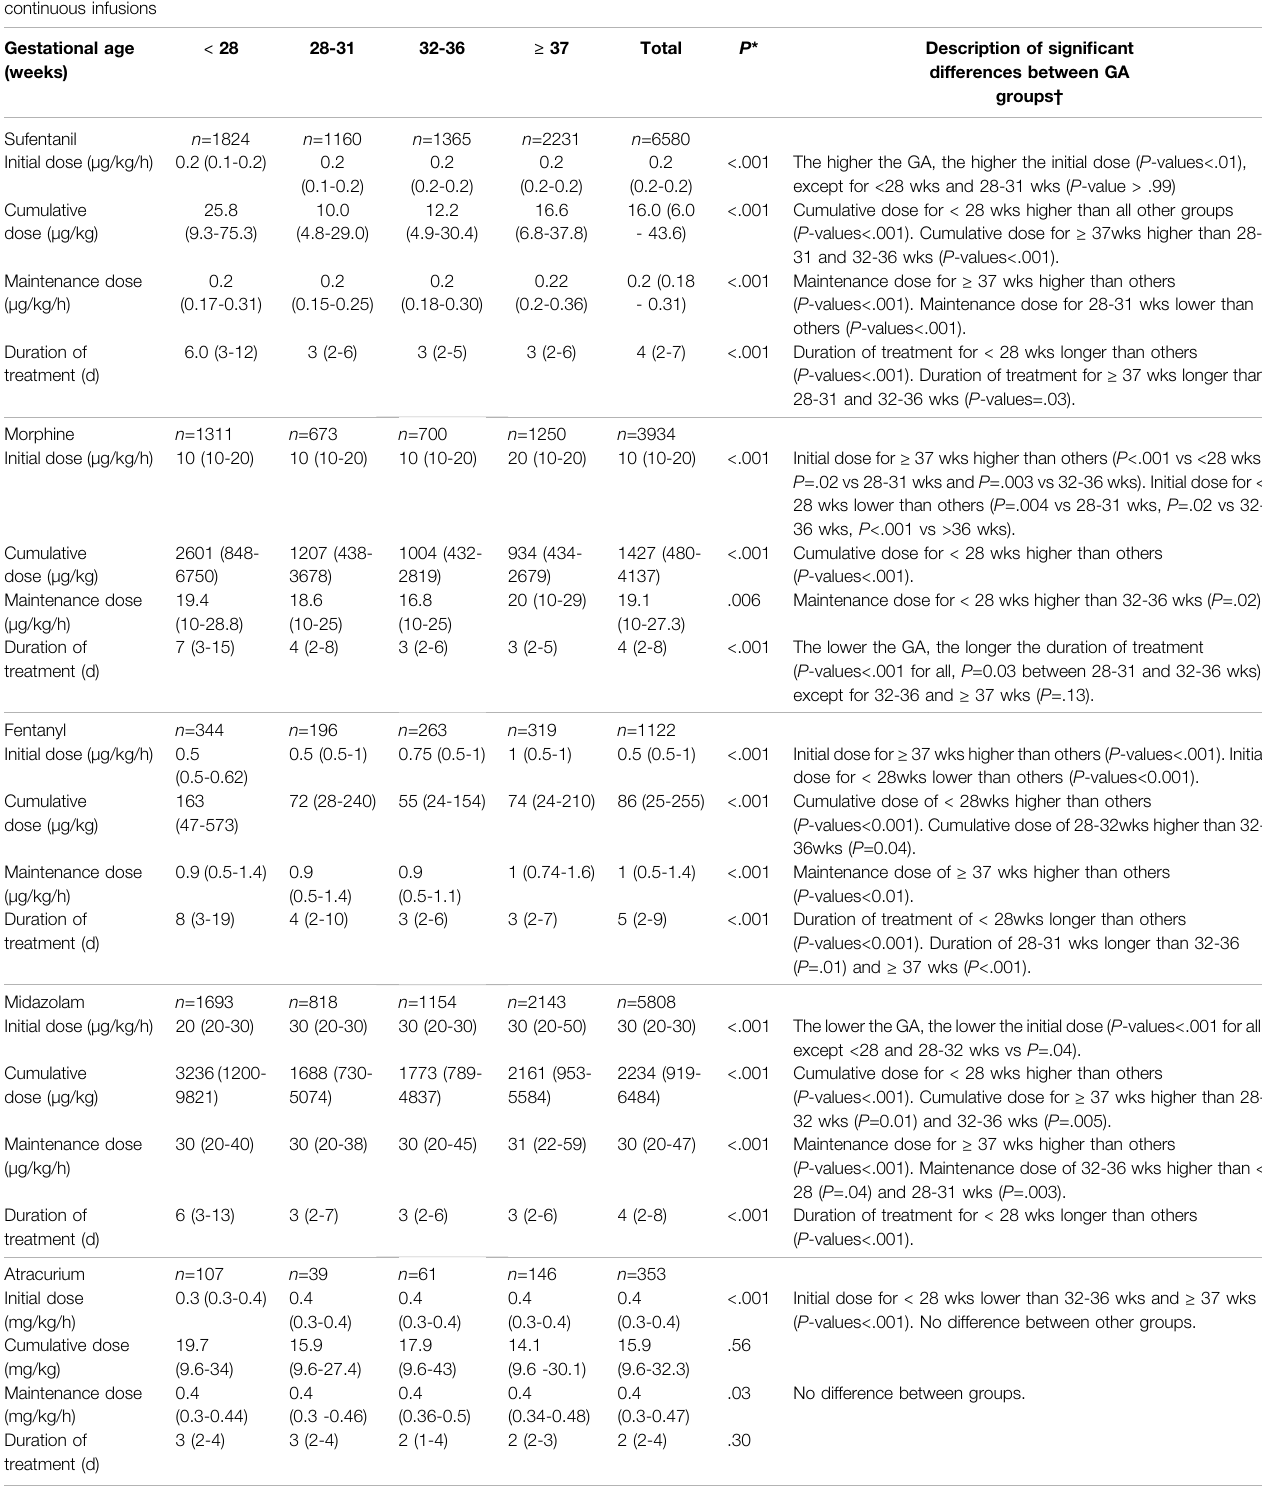
TABLE 5 | Comparison of initial dose, cumulative dose, maintenance dose, and duration of treatment by gestational age groups for drugs commonly prescribed as continuous infusions Gestational age < 28 28-31 32-36 ≥ 37 Total P * Description of signi fi cant (weeks)